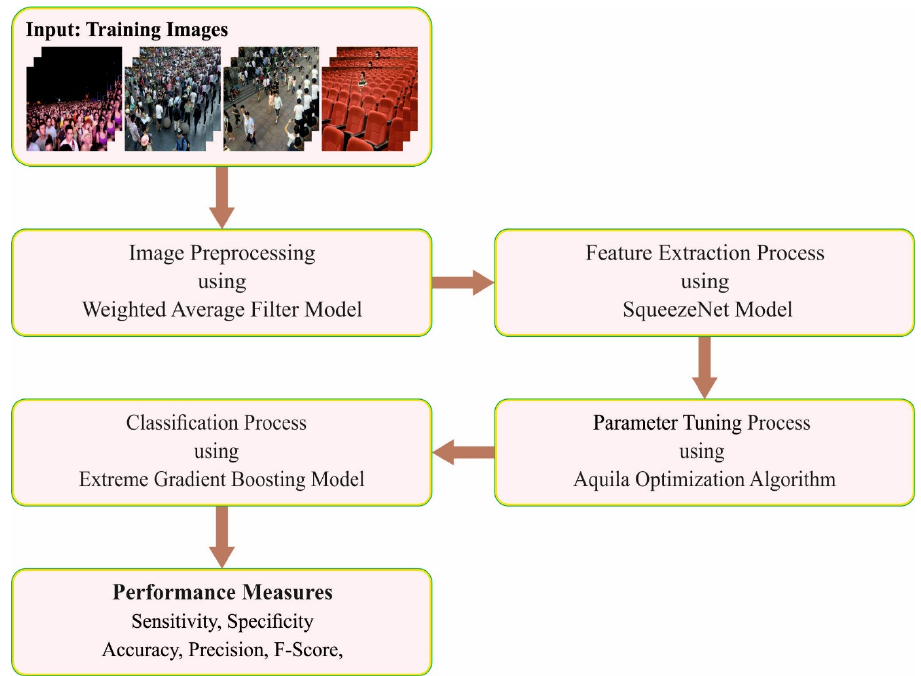
Figure 1. Block diagram of the AOTL-CDA3S system.